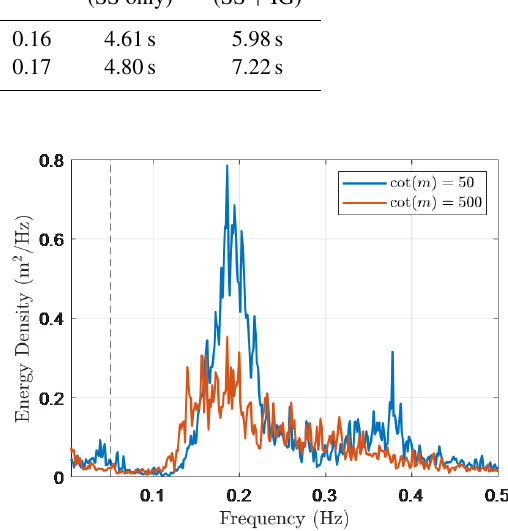
Figure 15. Results of XBeach non-hydrostatic numerical simula- tions showing wave spectra at the dike toe for a 1 : 50 and 1 : 500 foreshore slope, under the same offshore forcing conditions = 1m, T m − = 4 . 54s and h toe = 1m). Dashed ( H m 1 , 0 , deep 0 , deep vertical line indicates the frequency separating IG- and SS-wave